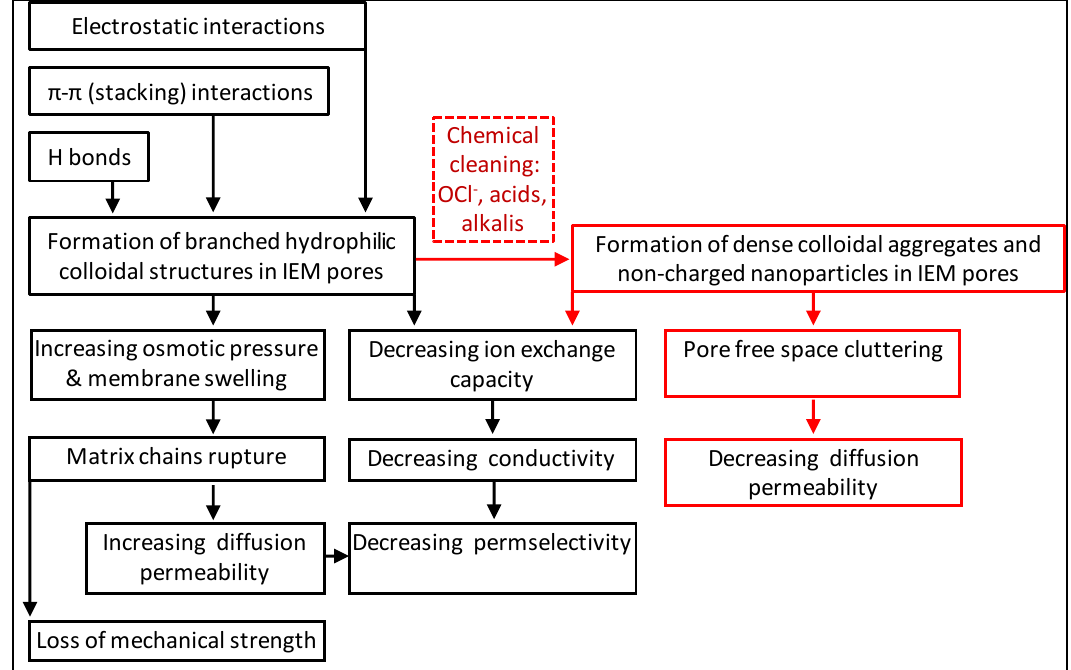
Figure 24. The main types of interaction of polyphenols with ion-exchange membranes and the effect of this fouling on the transport characteristics of IEMs. Adapted from [134].